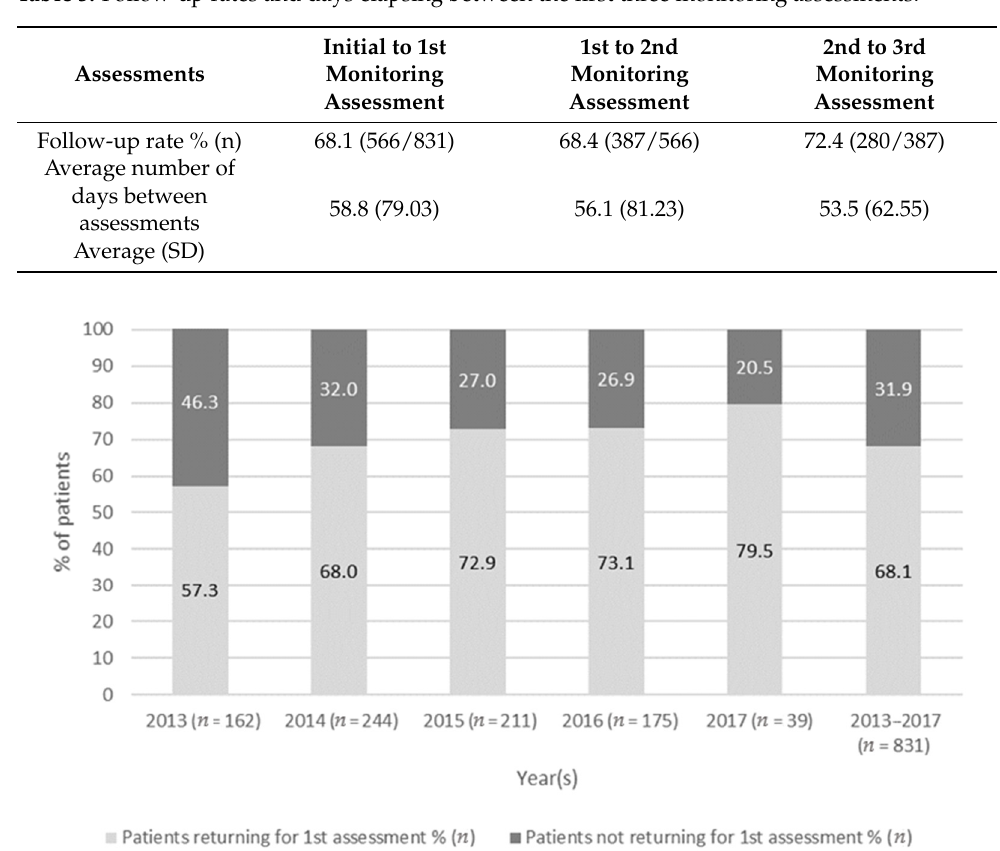
Figure 2. Follow-up rates of the first monitoring assessment between years 2013–2017 ( n = 831).